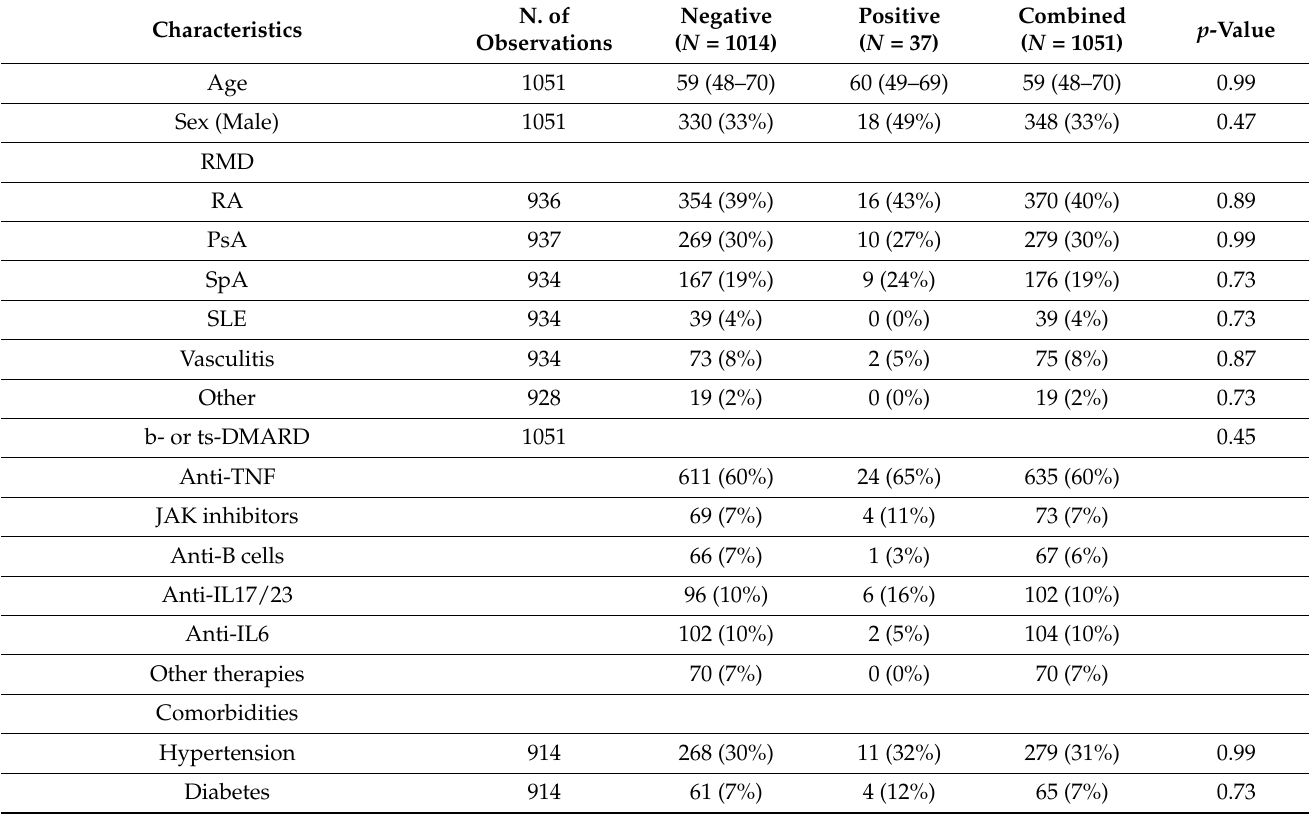
Table 1. Characteristics of RMD patients according to COVID-19 test